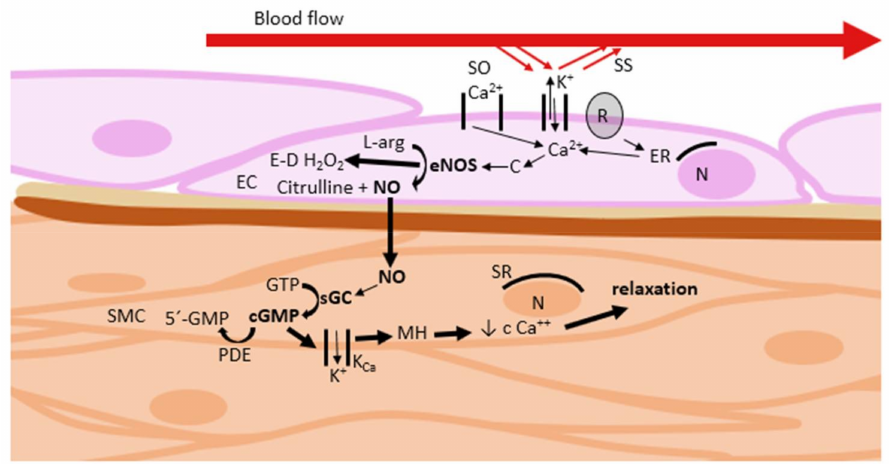
Figure 5. Regulation of vascular tone via nitric oxide–cyclic guanosine monophosphate pathway. C: calmodulin; cGMP: cyclic guanosine monophosphate; EC: endothelial cell; E-D H 2 O 2 : endothelium- derived H 2 O 2 ; eNOS: endothelial NO synthase; ER: endoplasmic reticulum; GTP: guanosine triphos- phate; K Ca : Ca 2+ -activated K + channels; L-arg: L-arginine; MH: membrane hyperpolarization; N: nucleus; NO: nitric oxide; PDE: phosphodiesterase; R: receptor; sGC: soluble receptor with guanylate cyclase activity; SMC: smooth muscle cell; SO Ca 2+ : store-operated Ca 2+ channels; SR: sarcoplasmic reticulum; SS: shear